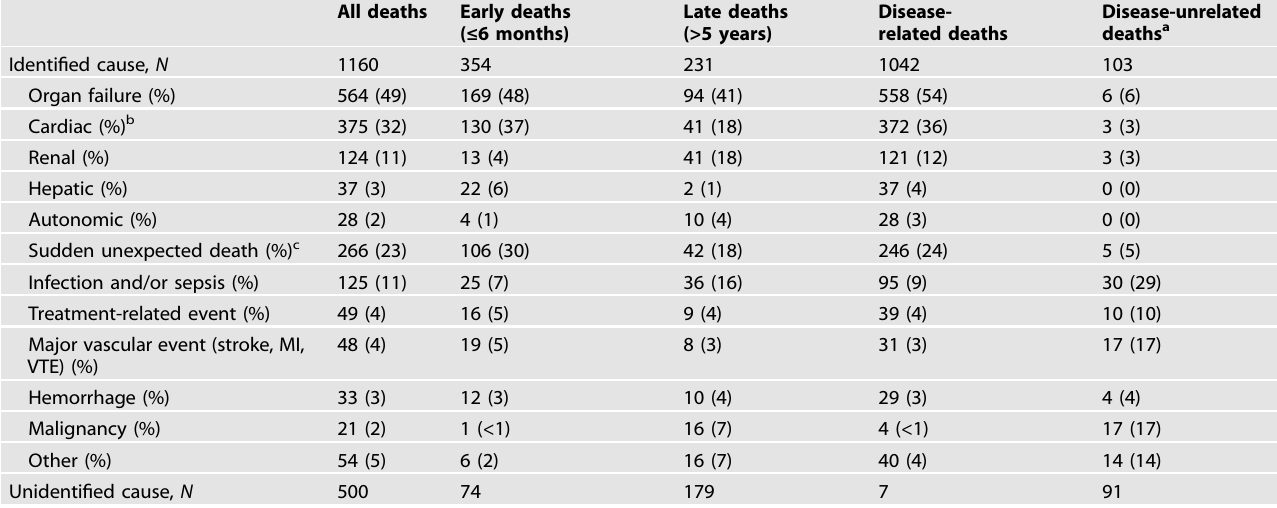
Table 5. Primary causes of death in the AL amyloidosis cohort.